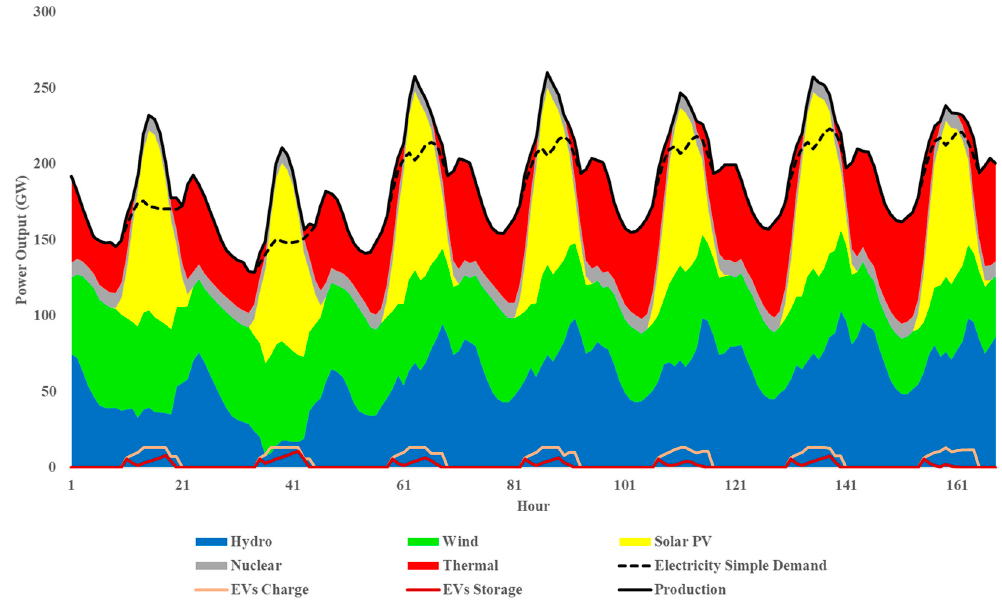
Figure 7. Power output on a spring week for scenario hydro risk—Daily charging strategy.